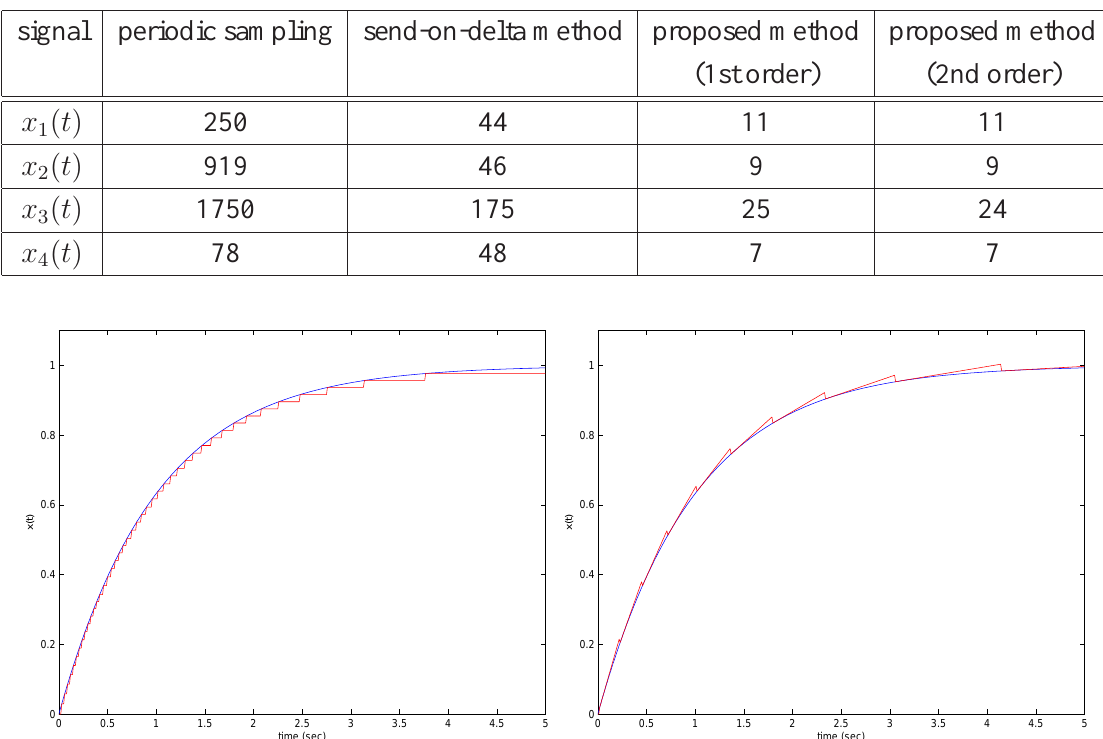
Table 4 . Number of sensor data transmission ( 0 ≤ t ≤ 5 , δ = 0 . 02 )